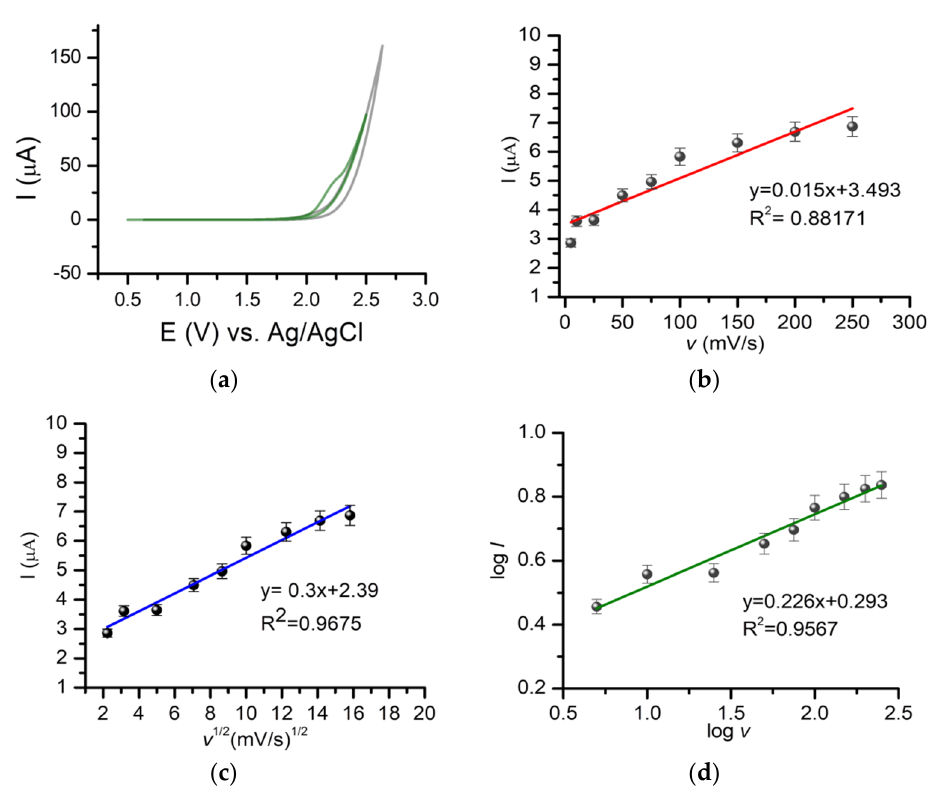
Figure 2 . ( a ) CVs obtained for a PBS solution of pH 7.4 (gray) and 25 μg/mL GMB standard solution (green) ( b ) The variation of the oxidation current with the scan rate. ( c ) The variation of the oxidation current with the square root of the scan rate. ( d ) Variation of log(I) with log(v).